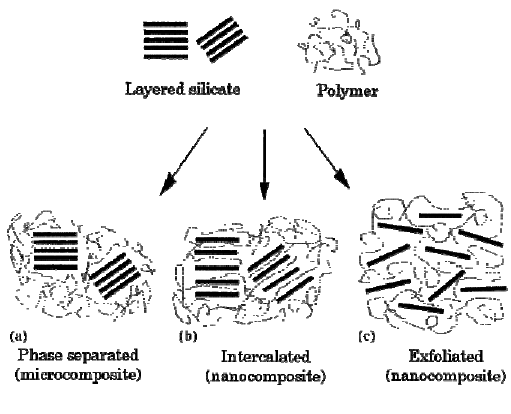
Figure 5. Schematic representation of different kinds of composites produced from interaction of layer compound with polymers: ( a ) phase separated; ( b ) intercalated and ( c ) exfoliated structures. Reprinted with permission from [116]. Copyright 2000 Elsevier.